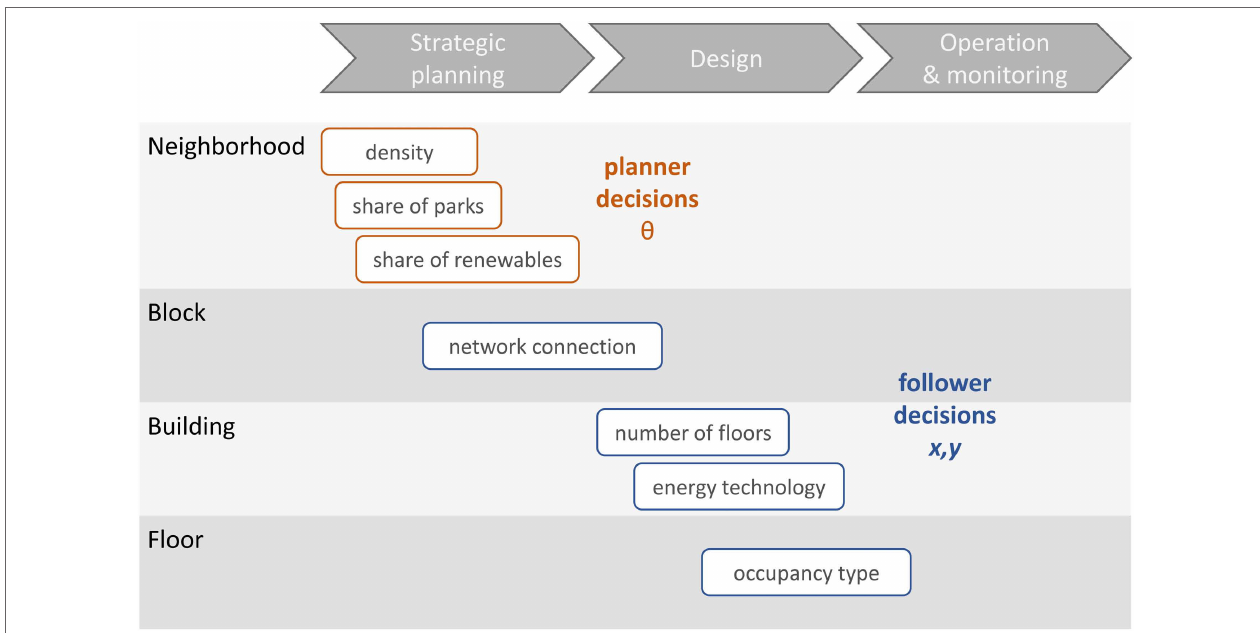
FIGURE 1 | Examples of decisions to be made by different actors during the phases of an urban planning process and being implemented on different scales.